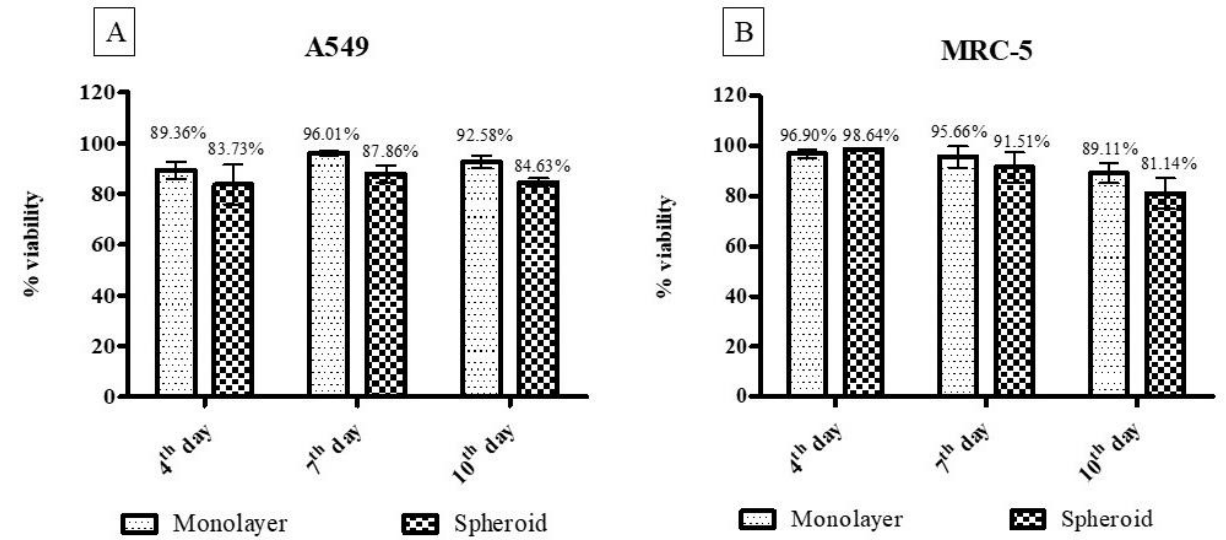
Figure 4. Cell viability results from the trypan blue method. In Figure ( A ), the comparative values between the monolayer and three-dimensional model for the A549 cell line are shown, and in ( B ), the same comparative results for the MRC-5 cell line are shown. There was no statistically significant difference.